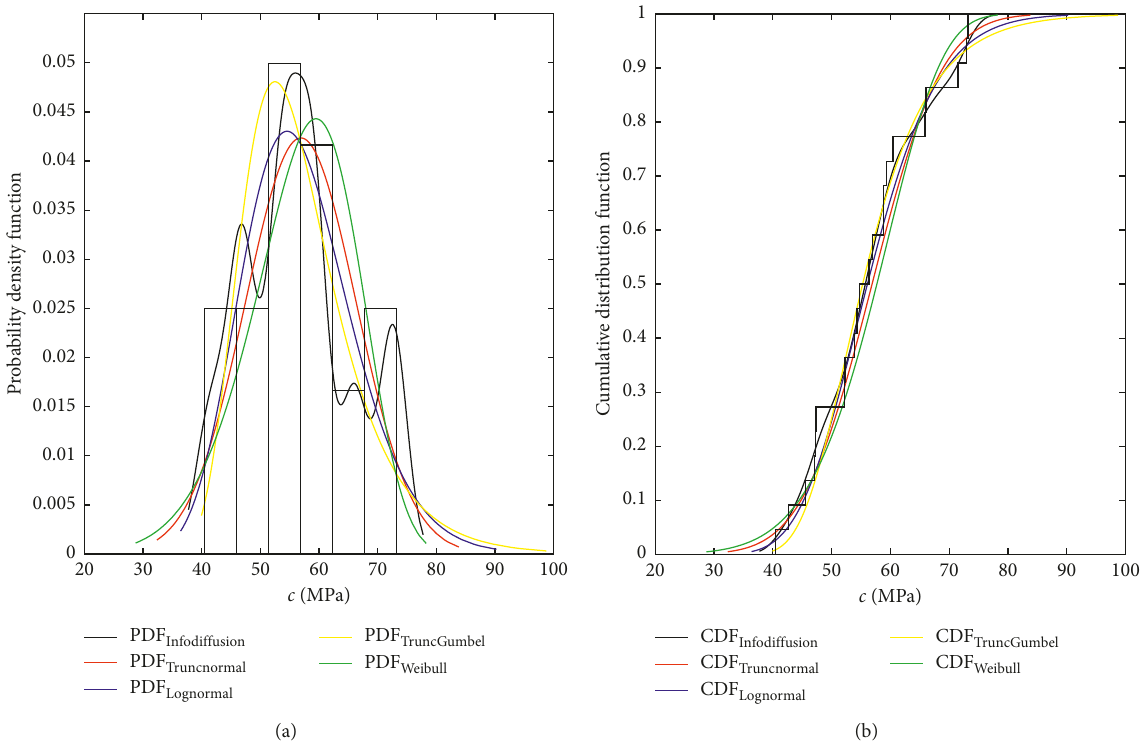
Figure 14: PDF and CDF plots of c ′ reproduced by Gaussian copula coupling different margins.